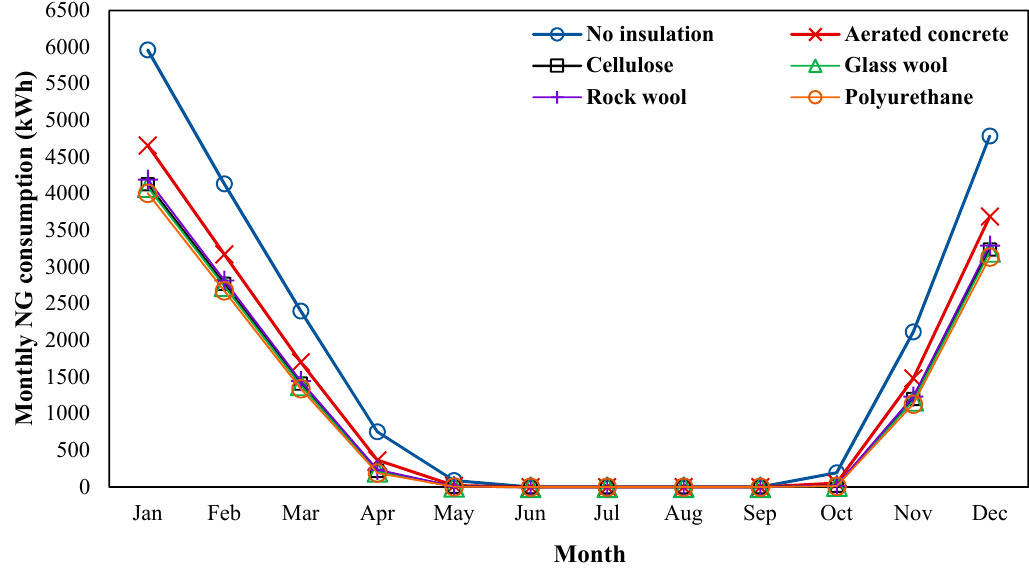
Figure 15. Monthly NG consumption for different insulation materials.